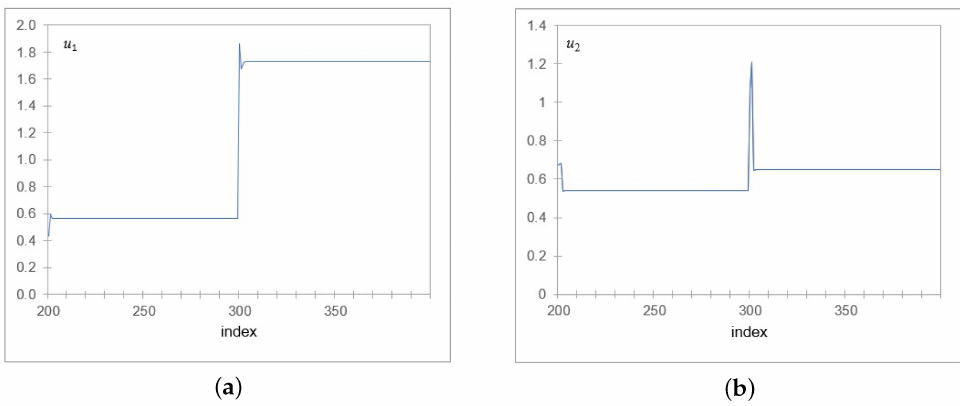
Figure 3. Control variables values: ( a ) u 1 ; ( b ) u 2